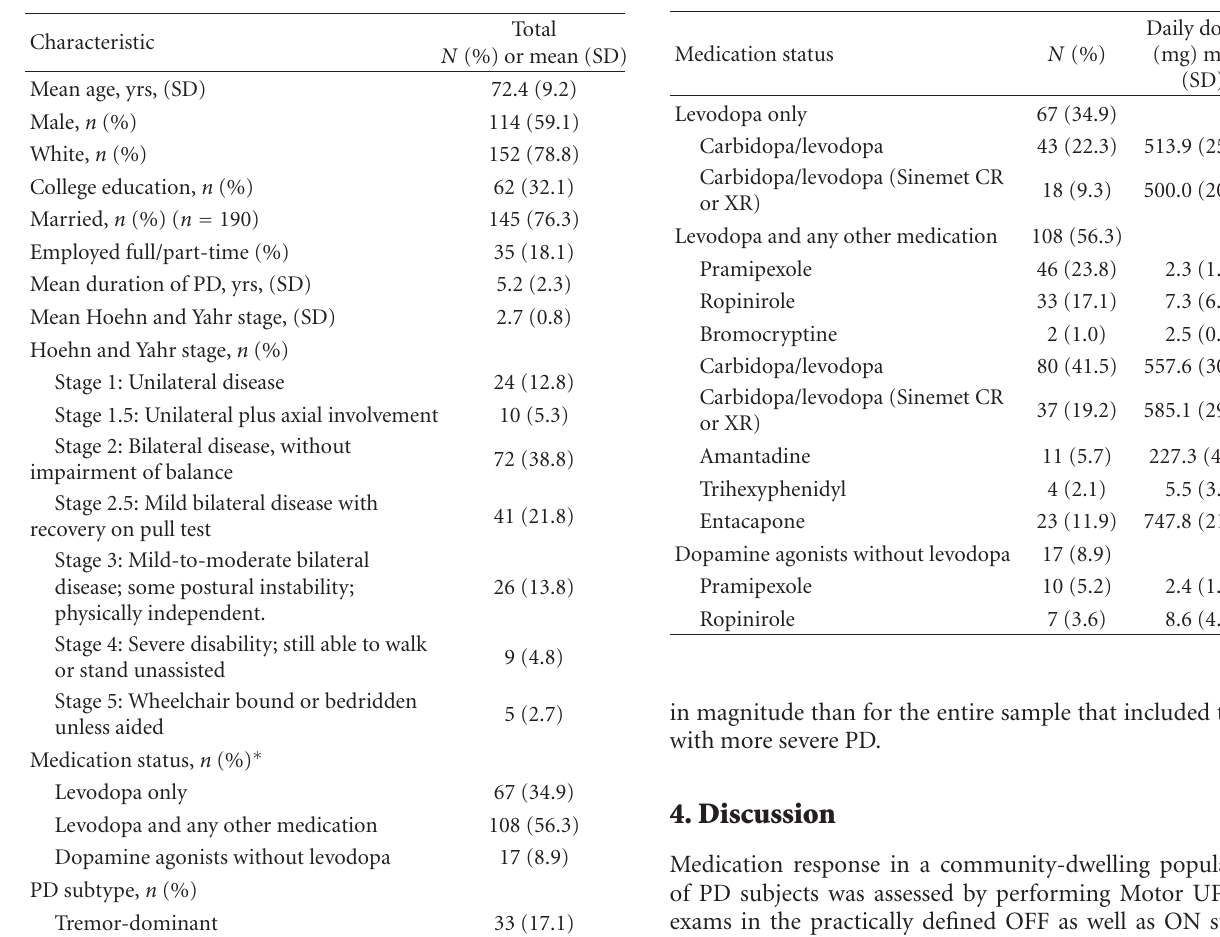
Table 1: Sample demographics ( n = 193). Table 2: Medications ( n =